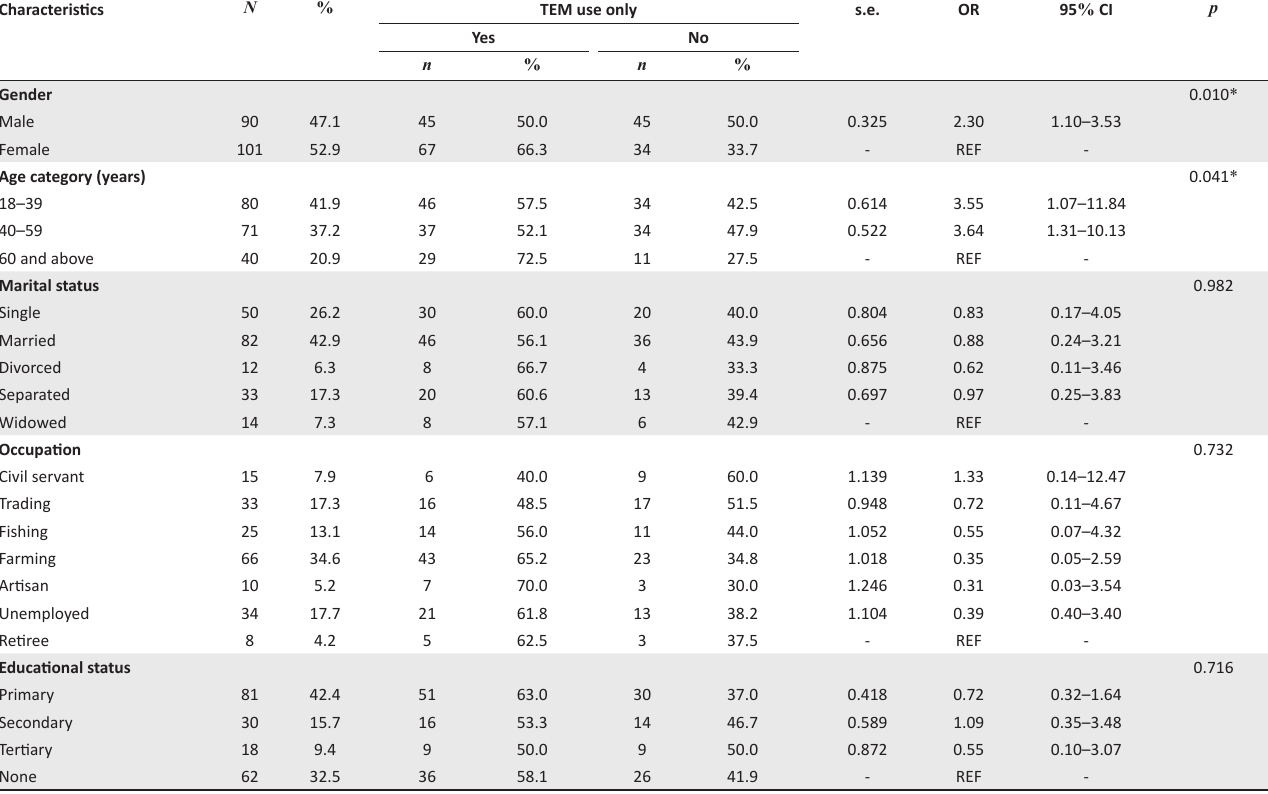
TABLE 2: Traditional eye medicine use only by demographic characteristics of the participants.